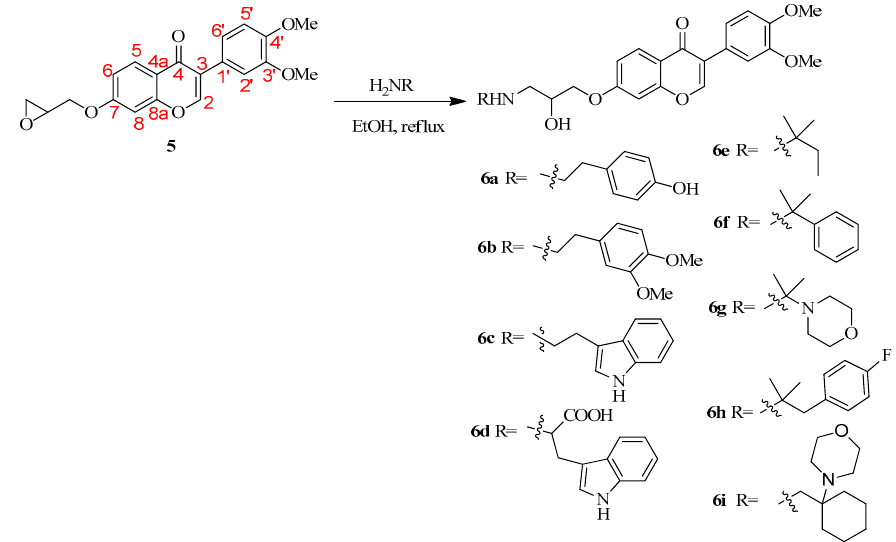
Table 1. 13 C (100 MHz), 1 H (400 MHz), HC HMBC and NOESY nuclear magnetic resonance (NMR) Data for 7-{3-[(3,4-dimethoxy phenethyl)amino]-2-hydroxypropoxy}-3-(3,4-dimethoxyphenyl)- 4H - chromen-4-one ( 6b ) in CDCl 3 . a 13 C 1 H b Position δ C